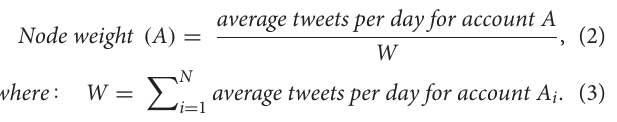
Frontiers in Artificial Intelligence |